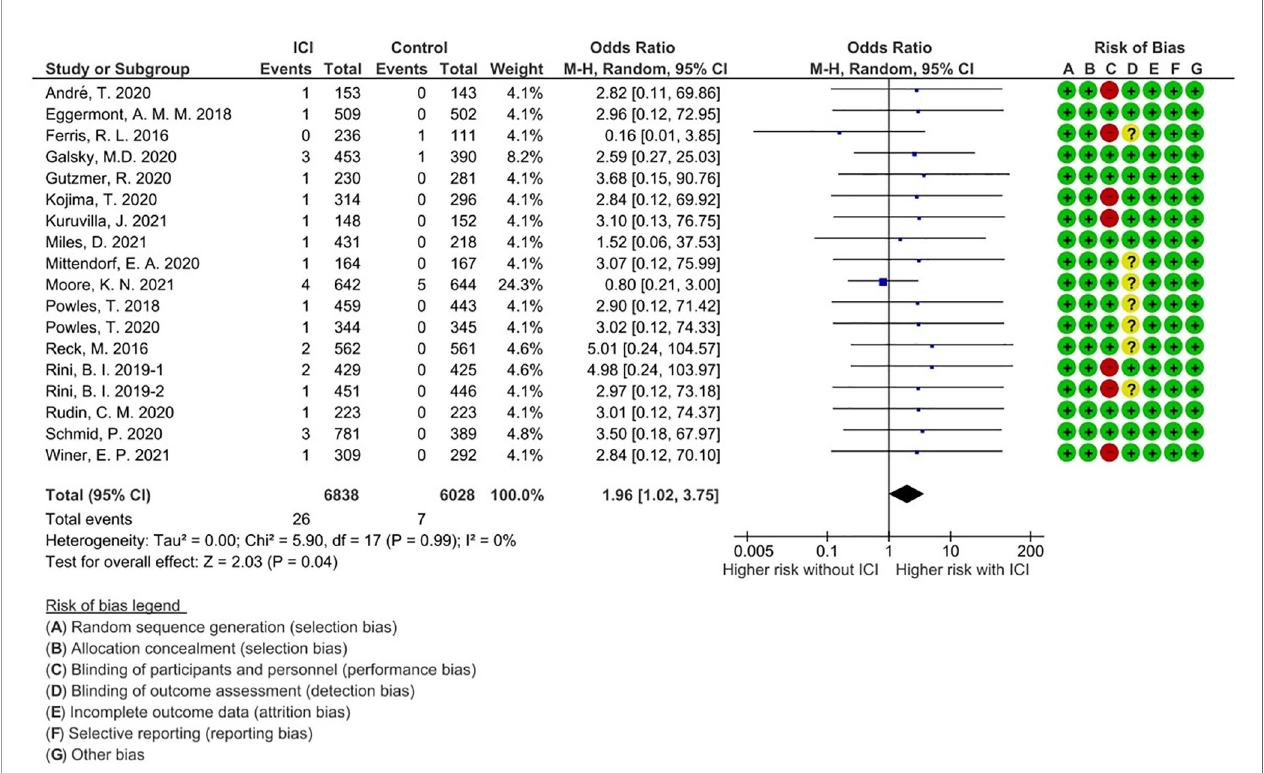
FIGURE 2 | Forest plot with risk of bias summary for incidence of immune checkpoint inhibitor-related